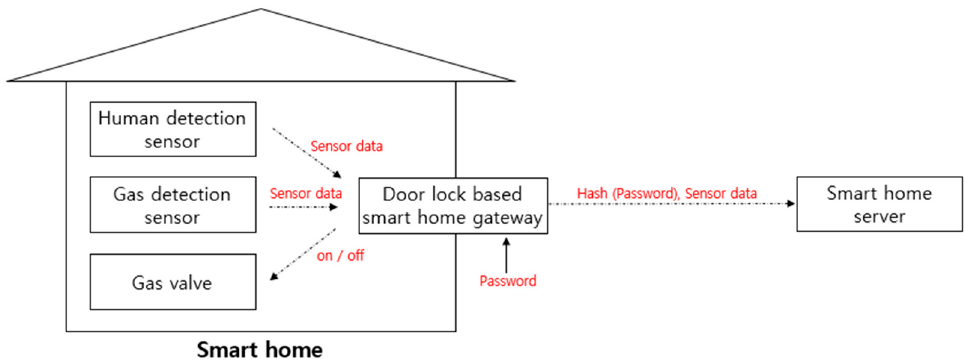
Figure 3. Low-performance IoT-based smart home service.